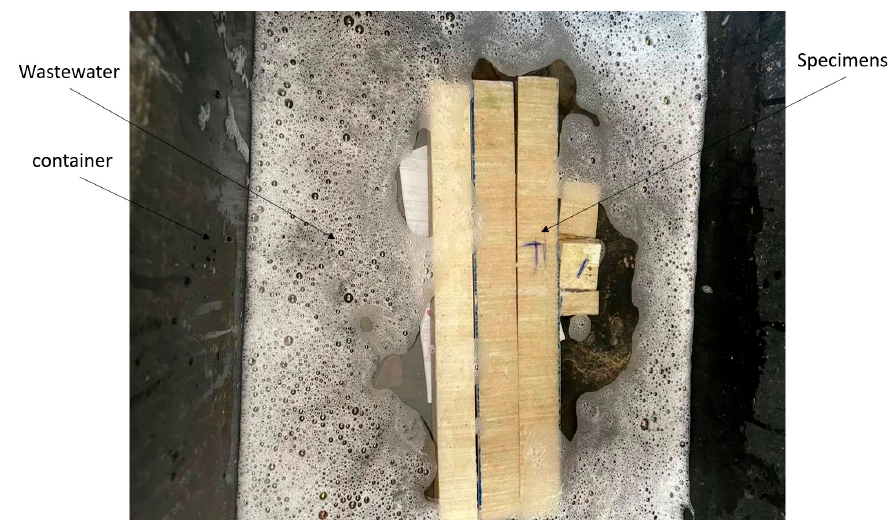
Figure 2. Chemical treatment to preconditioning the GRP pipes material.